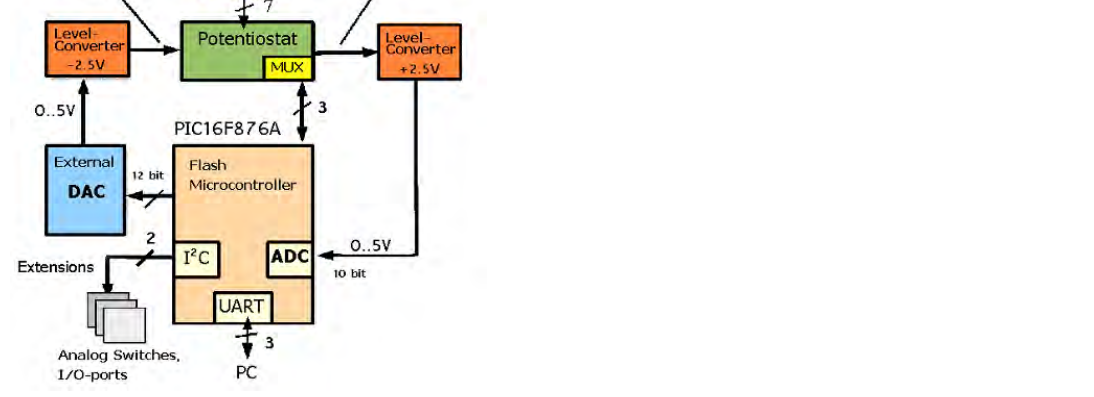
Figure 3. Block diagram of the electronics for the electronic tongue